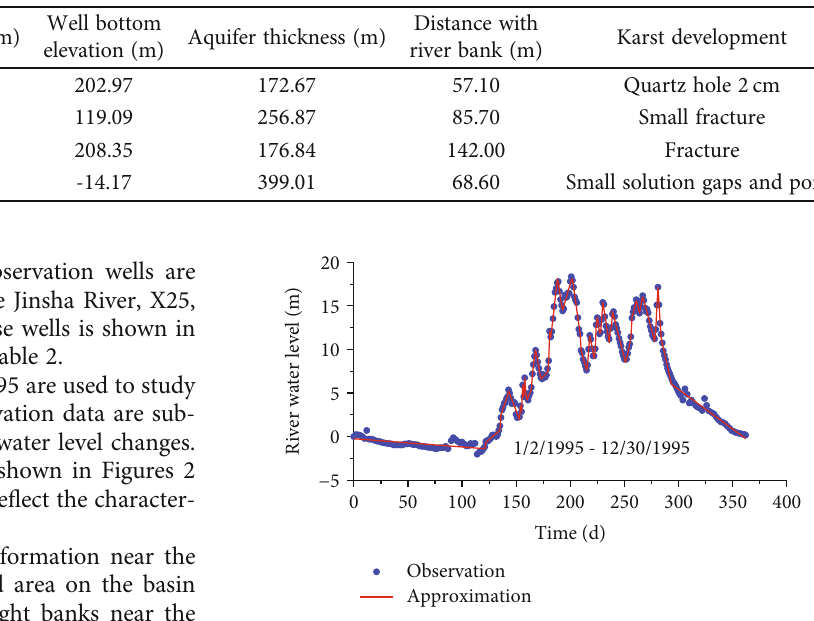
Figure 6: Location of study site and monitoring wells. Table 2: Information of observation wells.